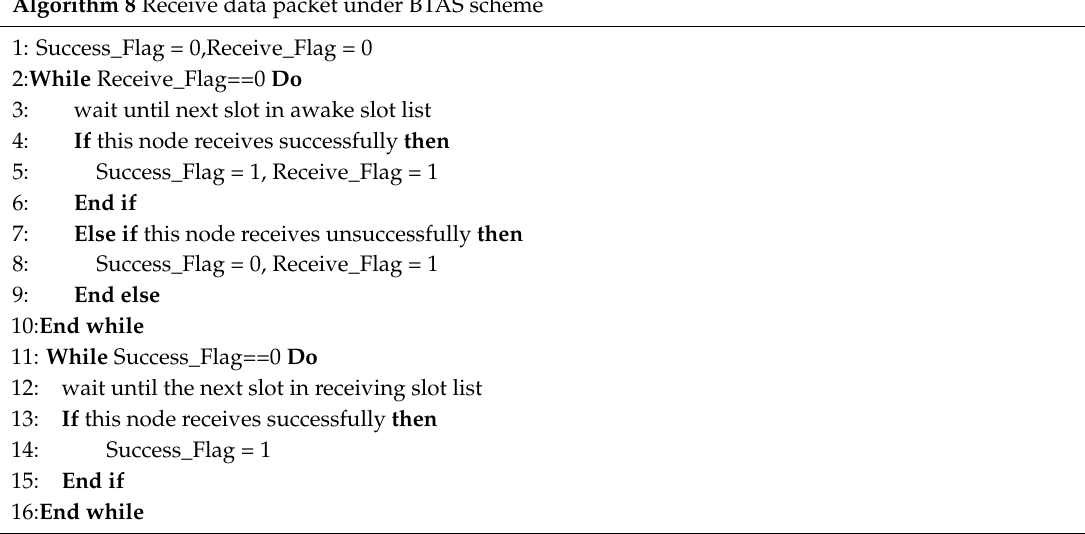
Algorithm 8 Receive data packet under BTAS